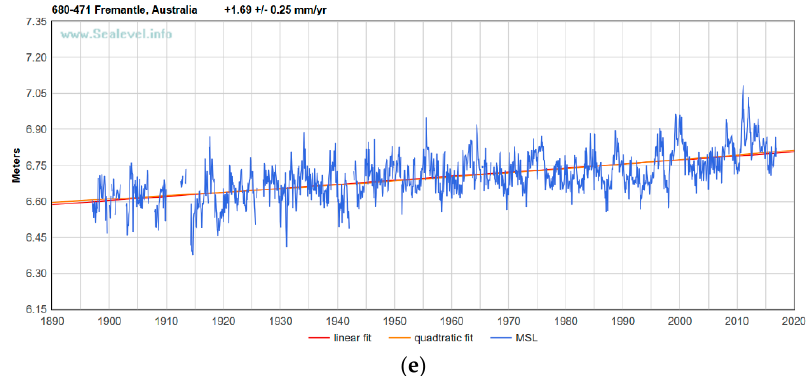
Figure 3. Aden MSL results. ( a ) Version ( n − 1), data sources are 795 months from the National Oceanic and Atmospheric Administration (NOAA). ( b ) Version ( n ), data source 815 months from Permanent Service for Mean Sea Level (PSMSL). Mumbai MSL results. ( c ) Data source 1465 months from PSMSL. Karachi MSL results. ( d ) Data source 673 months from PSMSL. Fremantle MSL results. ( e ) Data source 1331 months from PSMSL.